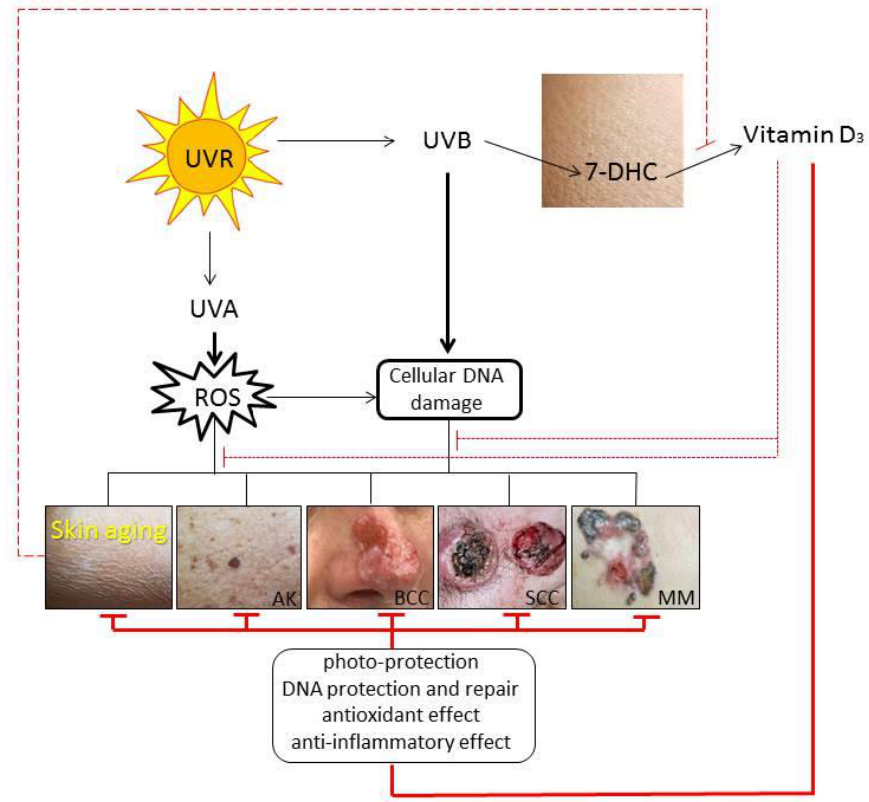
Figure 2. Photoprotective effects of vitamin D 3 in premature skin aging and cutaneous cancerogenesis. Abbreviations: 7-DHC, 7-dehydrocholesterol; AK, actinic keratosis; BCC, basal cell carcinoma; SCC, squamous cell carcinoma; MM, malignant melanoma.